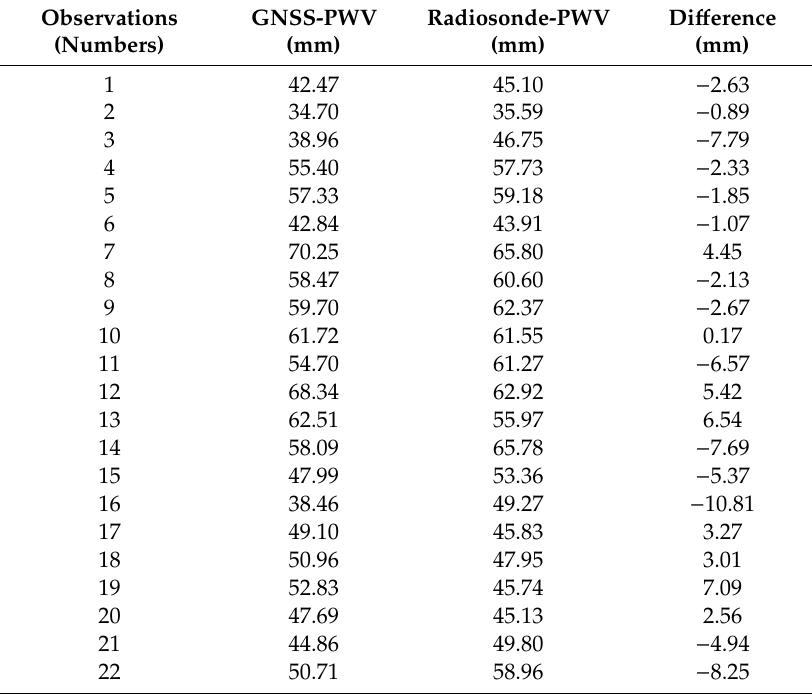
Figure 4. Comparison of shipborne GNSS-PWV against radiosonde observations. The slope of linear fitted trend the correlation coefficient (R) between GNSS-PWV and radiosonde-PWV is calculated with a linear regression model. Table 4. Comparisons between GNSS-PWV and radiosonde-PWV for a period from day-of-year (DOY) 242 to DOY 264, 2018 in the Pacific Ocean.